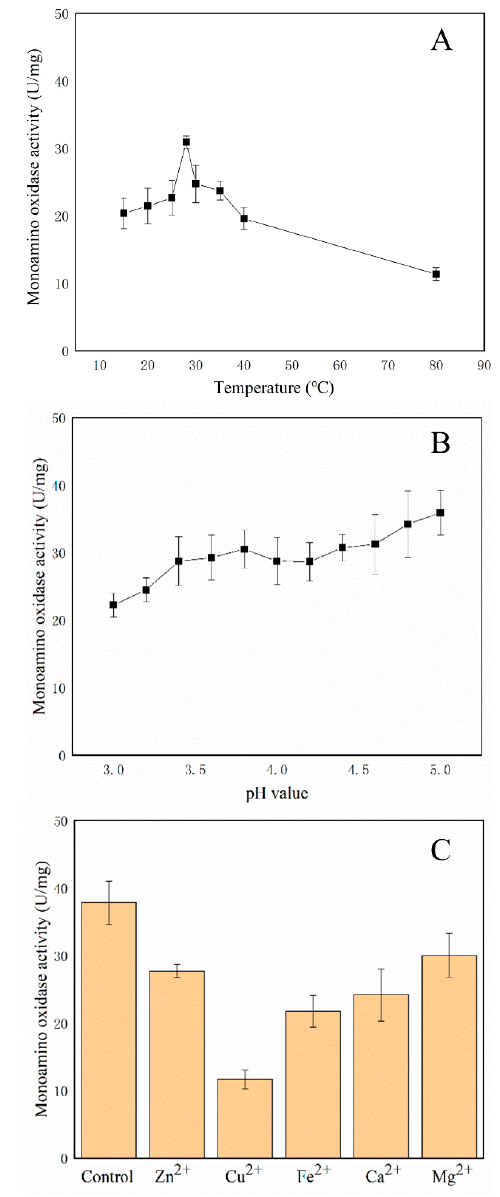
Figure 5. The monoamine oxidase (MAO) activity in the amine oxidase mixture at different ( A ) at pH 4.0 for 2 h; di ff erent pH ( B ) at 30 ◦ C for 2 h and di ff erent metal ions ( C ) at 30 ◦ C for 2 h temperatures ( A ) at pH 4.0 for 2 h; different pH ( B ) at 30 °C for 2 h and different metal ions ( C ) at 30 (pH °C for 2 h (pH 4.0).